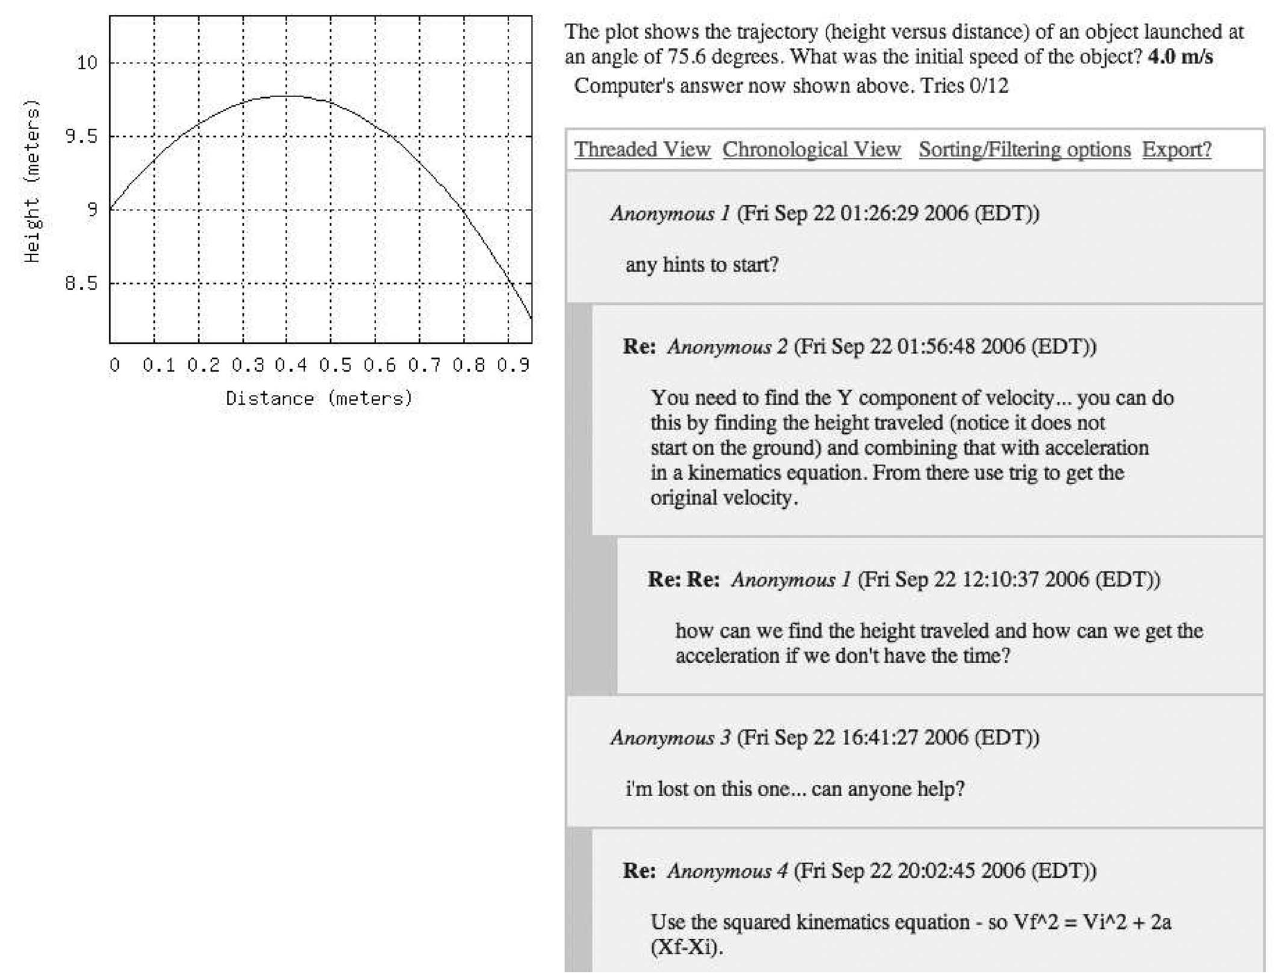
FIG. 1. Example of an online homework problem with associated student discussions. The problem is past its due date, so the correct answer is shown. If it were still open, the students would have one text answer box, into which they would enter the value with physical units. The students in this example chose to post anonymously, however, the student name is still available to